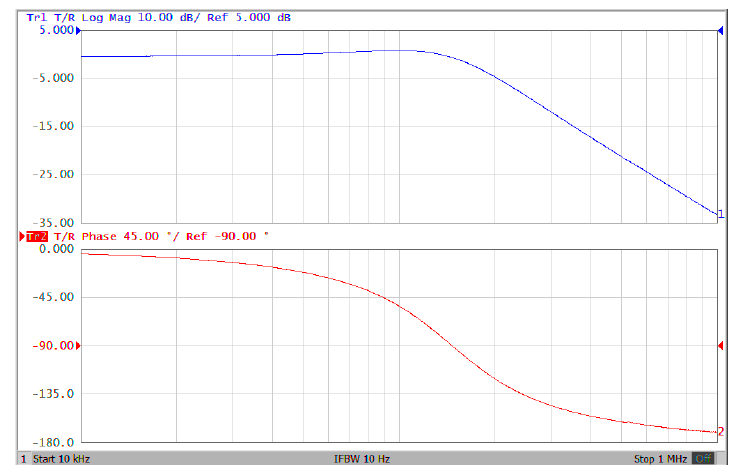
Figure 31. Experimentally observed gain and phase responses of the LP filter realized in case I.